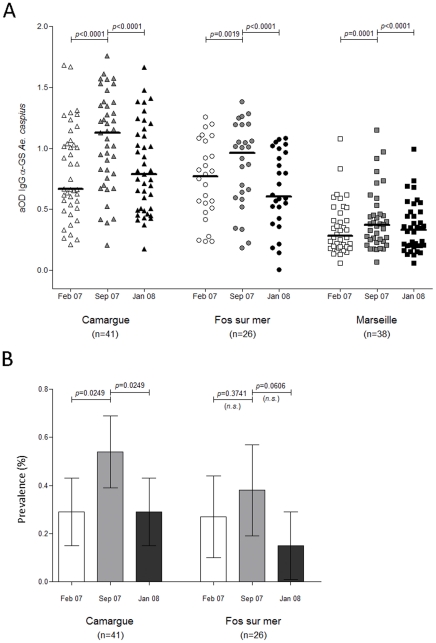
Spatial and seasonal variations of IgG responses to Ae. caspius salivary gland protein extracts.(A) IgG serum levels against Ae. caspius salivary gland protein extracts. Scatter plots of IgG antibody responses against Ae. caspius salivary gland extracts in individuals from Marseille (squares), Fos-sur-mer (circles) and Camargue (triangles) at three times February 07 (T1), September 07 (T2) and January 08 (T3), are presented with the sampling time indicated in white, grey and black symbols, respectively. Antibody responses are represented by aOD: the mean OD value of wells with antigen minus the mean OD value of wells without antigen. Each point shows the aOD value for a single individual. Horizontal bars show medians. Differences between the two time points at a single site were tested using the Wilcoxon signed-rank test. p-values are indicated. (B) Seasonal variation of seroprevalence against Ae. caspius salivary gland protein extracts at the three study sites. Seroprevalence against Ae. caspius salivary gland extracts in individuals from Fos-sur-mer and Camargue at three times February 07 (T1, white bars), September 07 (T2, light grey bars) and January 08 (T3, dark grey bars) are represented. Whiskers indicate the 95% confidence interval. The p values were determined by the chi-squared test.